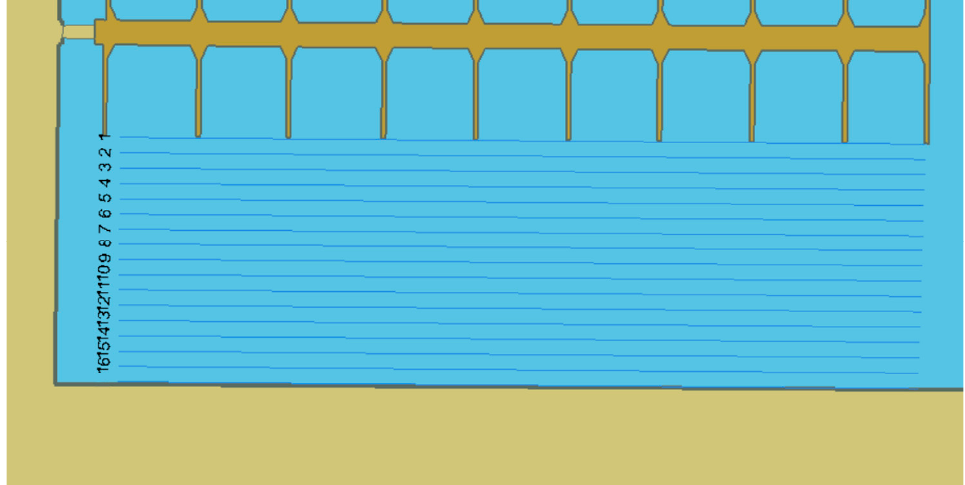
Figure 2. Survey lines in the area od study.